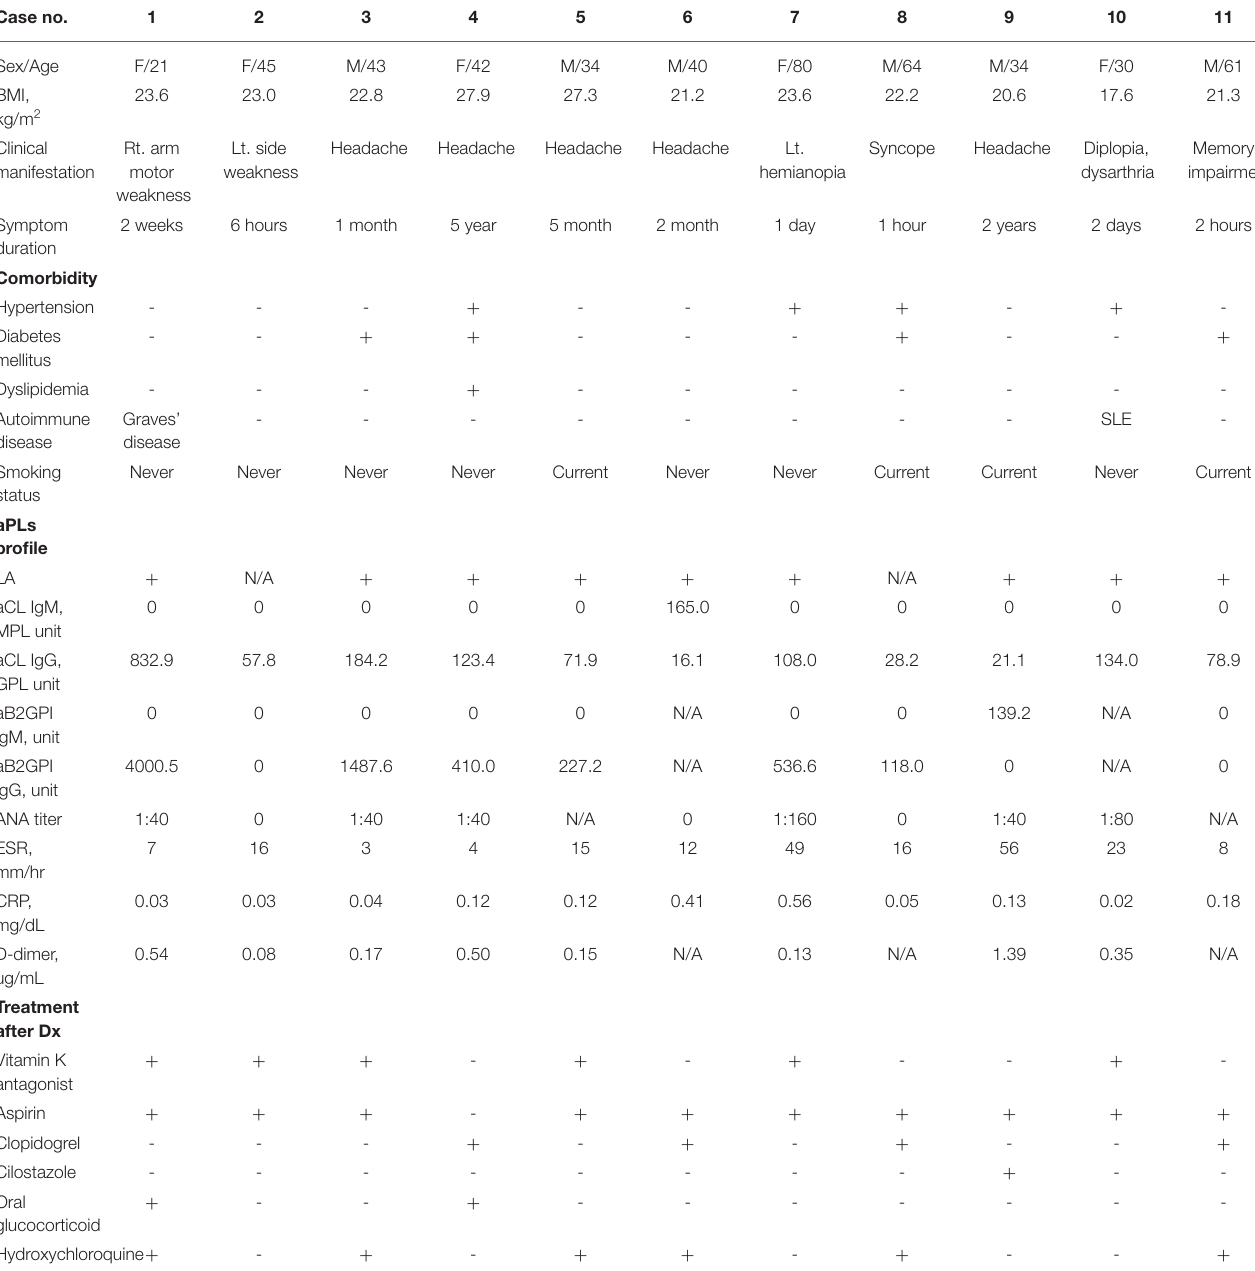
TABLE 1 | Clinical characteristics of patients with PV-aPL. Case